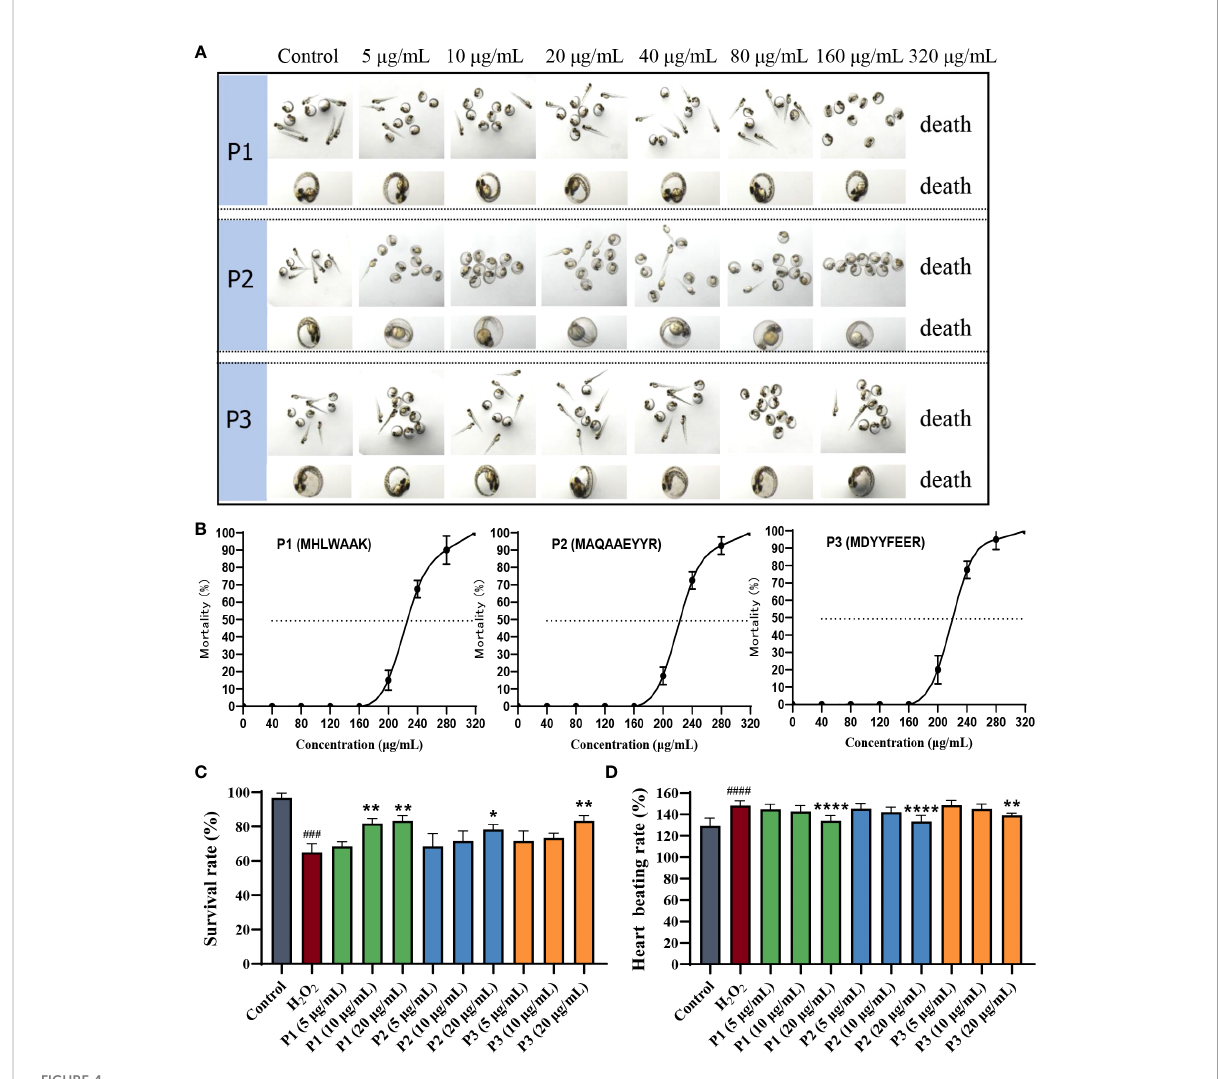
FIGURE 4 Protective effect of antioxidant peptides on H 2 O 2 -induced oxidative damaged in zebra fi sh embryos. (A) The morphology of zebra fi sh larvae at 48 hpf. (B) The mortality of zebra fi sh larvae at 48 hpf. (C) Survival rates. (D) Heart beating rates. * p < 0.05, **p < 0.01, **** p < 0.0001 vs. the H 2 O 2 group. ### p < 0.001, #### p < 0.0001 vs. the blank control